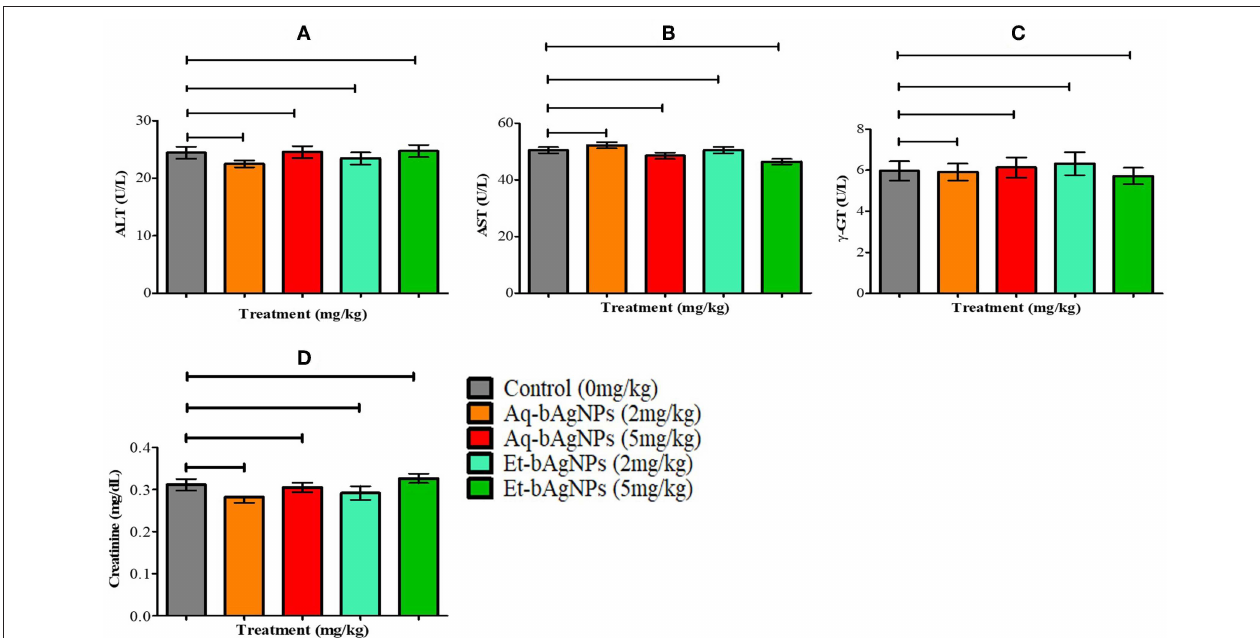
FIGURE 7 | In vivo cytotoxicity assay. The effect of bAgNPs on liver function was investigated by measuring the levels of ALT (A) , AST (B) , and γ -GT (C) . The effect of bAgNPs on kidney function was also investigated by measuring the level of serum creatinine (D) . The values presented are mean ± SE of multiple samples (six animals per group). Data were analyzed by GraphPad Prism 5.0 (GraphPad software) using one-way ANOVA test. Dunnett test was used for post hoc comparison. No significant difference was observed when treatment groups were compared with control and P >